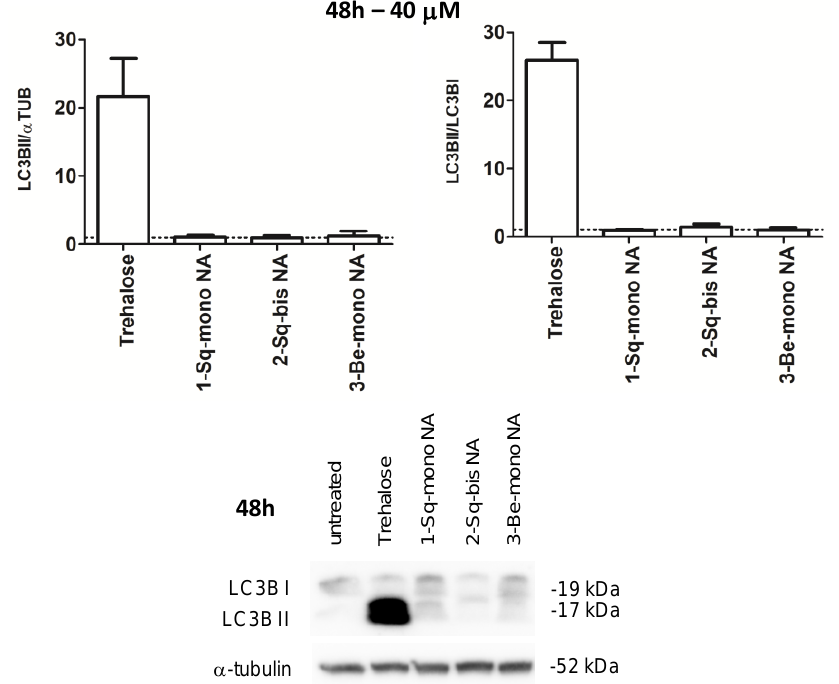
Figure 6. Autophagy induction on mono-Sq-NA1 , bis-Sq-NA2 and mono-Be-NA3 . LC3BII amount ( left ), LC3BII / LC3BI ratio ( right ), 48 h / 40 µ M, trehalose = 100 mM).